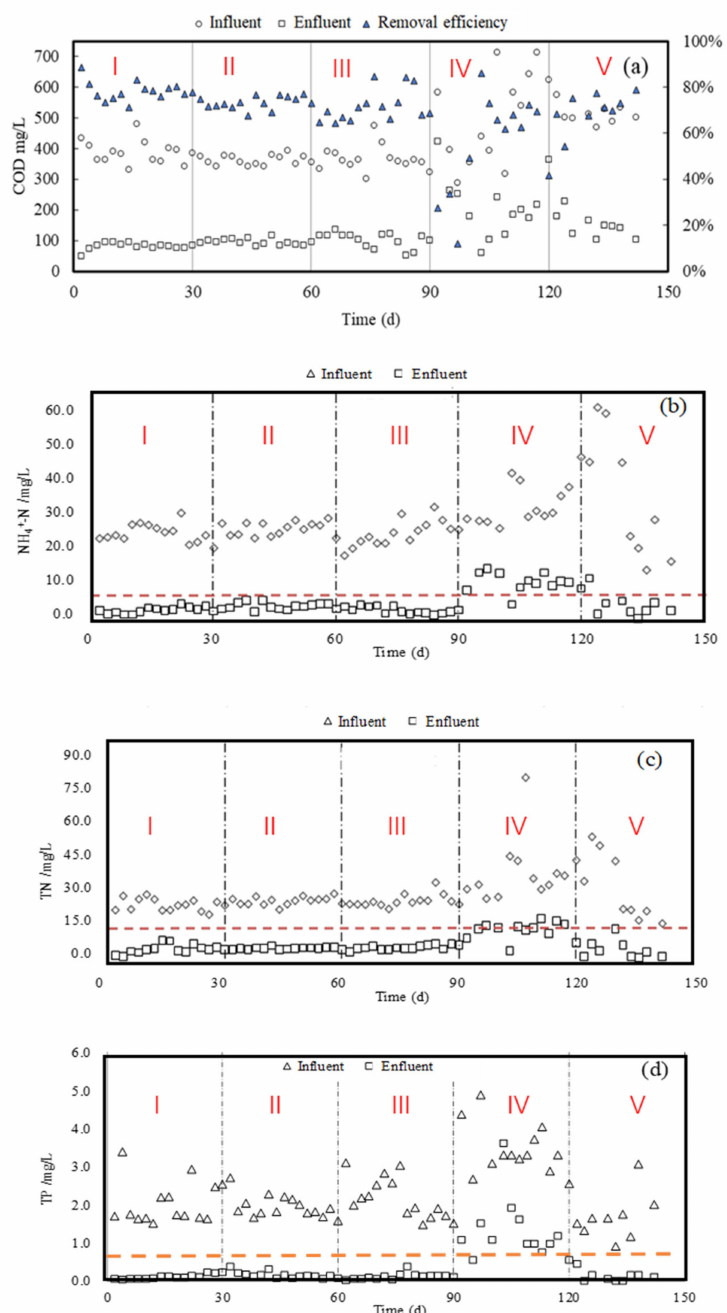
Figure 3. The variation of major water quality parameters in five stages with di ff erent mixing ratios of PW and DW: ( a ) chemical oxygen demand (COD), ( b ) NH 4 + -N, ( c ) total nitrogen (TN), and ( d ) total phosphorus